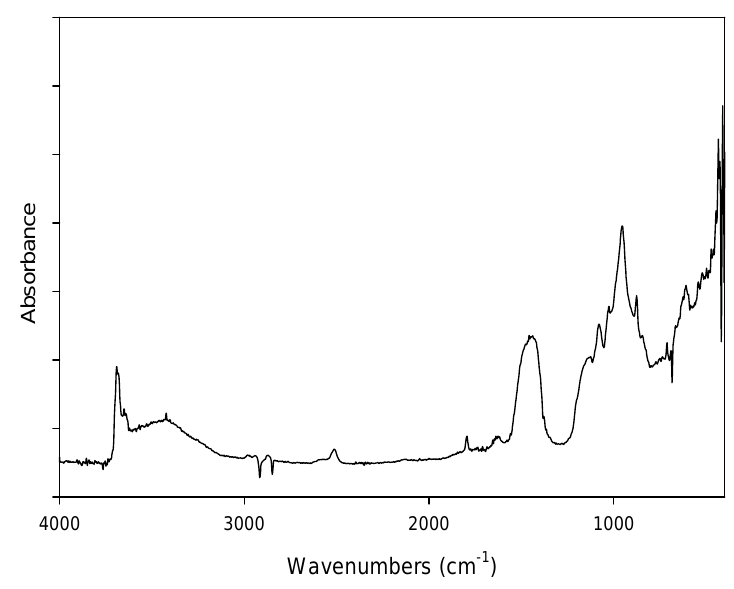
Figure 1. Diffuse reflectance infrared Fourier transform (DRIFT) spectrum of the asbestos containing material (ACM) sample.